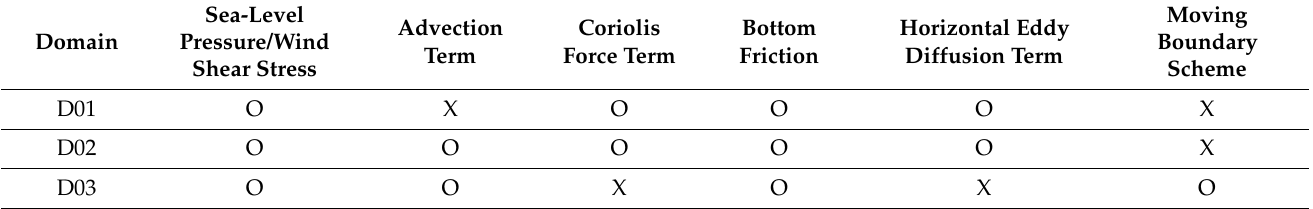
Table 4. Switches for advection term, forcing terms, and moving boundary scheme. O indicates the switch is turned on; X indicates the switch is turned